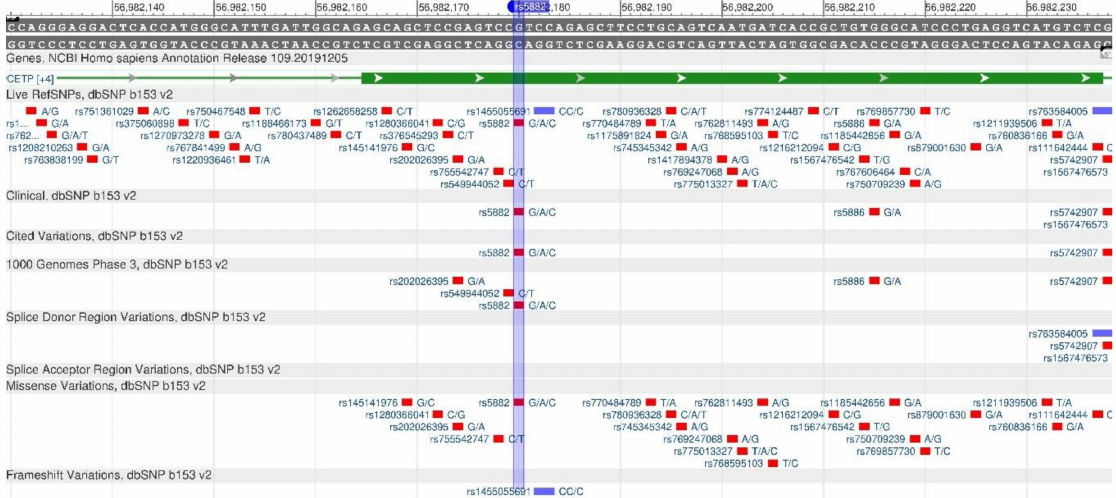
Figure 7. A portion of the CETP gene (located on the long (q) arm of chromosome 16) containing the oligonucleotide polymorphism